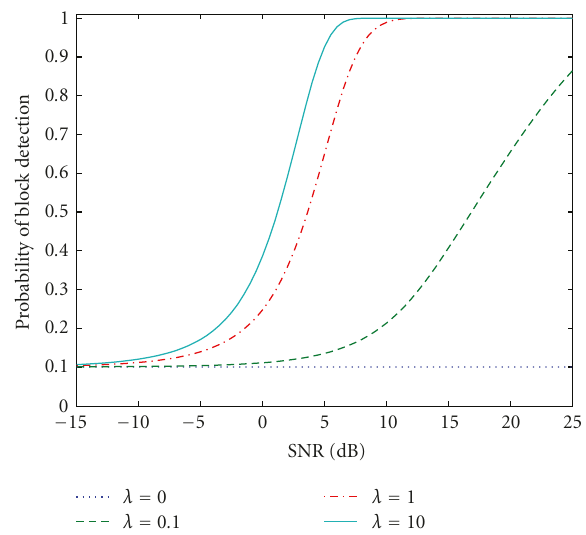
Figure 5: Probability of block detection versus SNR for ε i = e − λ ( i − 1) for i = 1, ... , N b , n = 10, N 1 = 25, and N b =